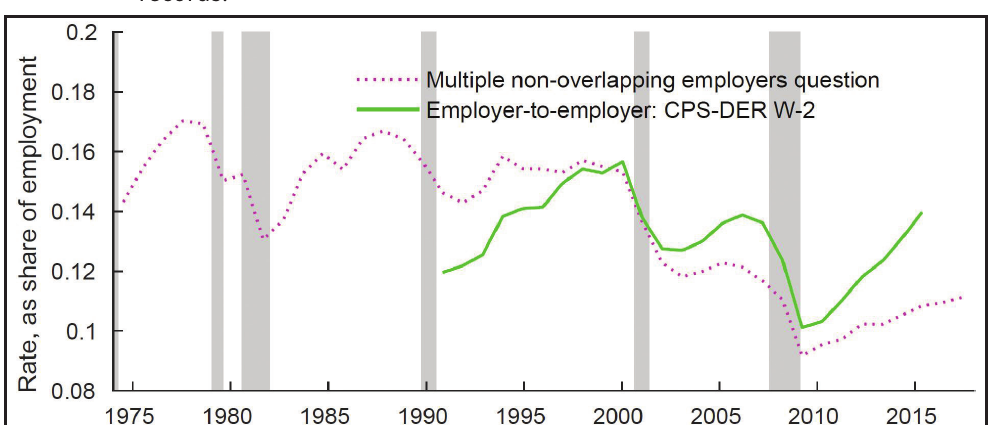
Figure E5 CPS-ASEC Multiple non-overlapping employers question vs. administrative